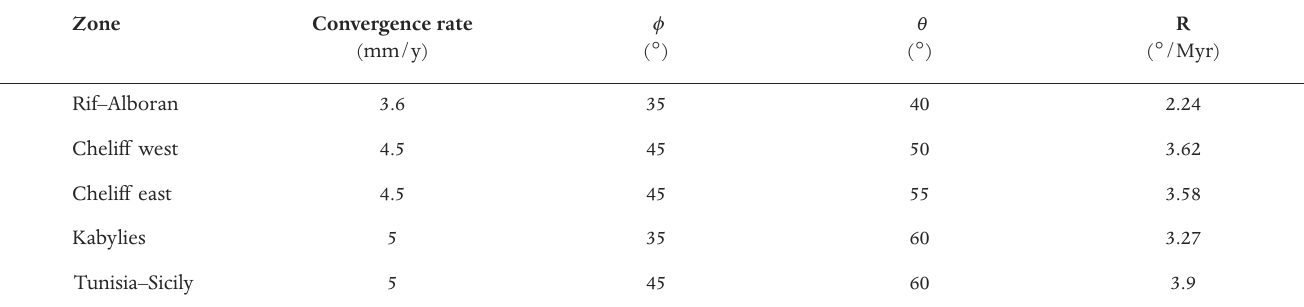
Table 2. The clockwise rotation rates, R , calculated for the small tectonic blocks, and averaged for main tectonic zones along the North Africa plate boundary. See Figure 1b and explanation in main text for the model of block rotation and transpression. Convergence rates and strikes i are from NUVEL-